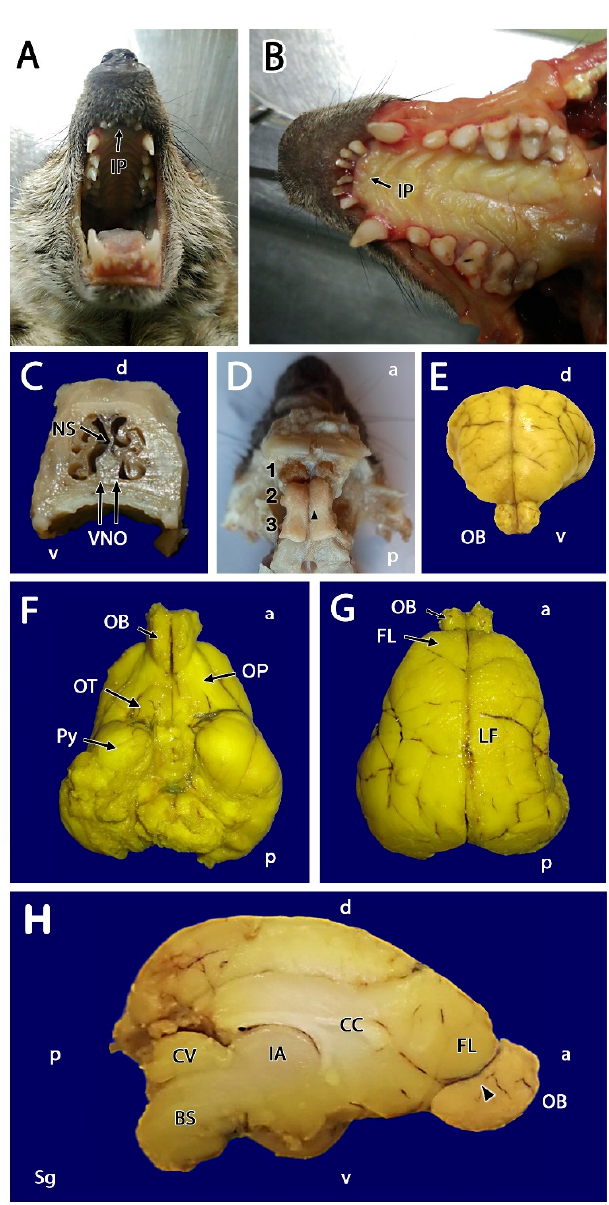
Figure 1. Main macroscopic features of the vomeronasal system of the meerkat. ( A ) Cranioventral view of the palate allows the identification of the incisive papilla (IP) area. ( B ) The IP is visible after the removal of the mandible. ( C ) Transverse section of the nasal cavity at the level of the first premolar, showing the vomeronasal organ (VNO) at the base of the nasal septum (NS), on both sides of the vomer bone (right). ( D ) Dorsal view of a dissection of the OB. The skull has been removed and the frontal lobe has been extracted. The presumptive area of localization for the right accessory olfactory bulb is indicated (arrowhead). 1, Ethmoidal conchae; 2, Olfactory bulb; 3, Olfactory peduncle. ( E ) In the rostral view of the brain is visible the development of the olfactory bulbs (OB) and their topographical relationship with the frontal lobe of the telencephalon. ( F ) Ventral view of the brain showing the olfactory system of the meerkat: olfactory bulb (OB), olfactory peduncle (OP), olfactory tubercle (OT), and pyriform lobe (Py). ( G ) Dorsal view of the brain showing the longitudinal fissure of the telencephalon (LF) as well as the arrangement and relative size of the olfactory bulbs. ( H ) Medial view of the left hemiencephalon showing the following anatomical structures: corpus callosum (CC), interthalamic adhesion (IA), brainstem (BS), cerebellar vermis (CV), frontal lobe (FL), and olfactory bulb (OB). The black arrowhead points to the presumptive area of localization of the accessory olfactory bulb. a, anterior; d, dorsal; p, posterior; v, ventral.